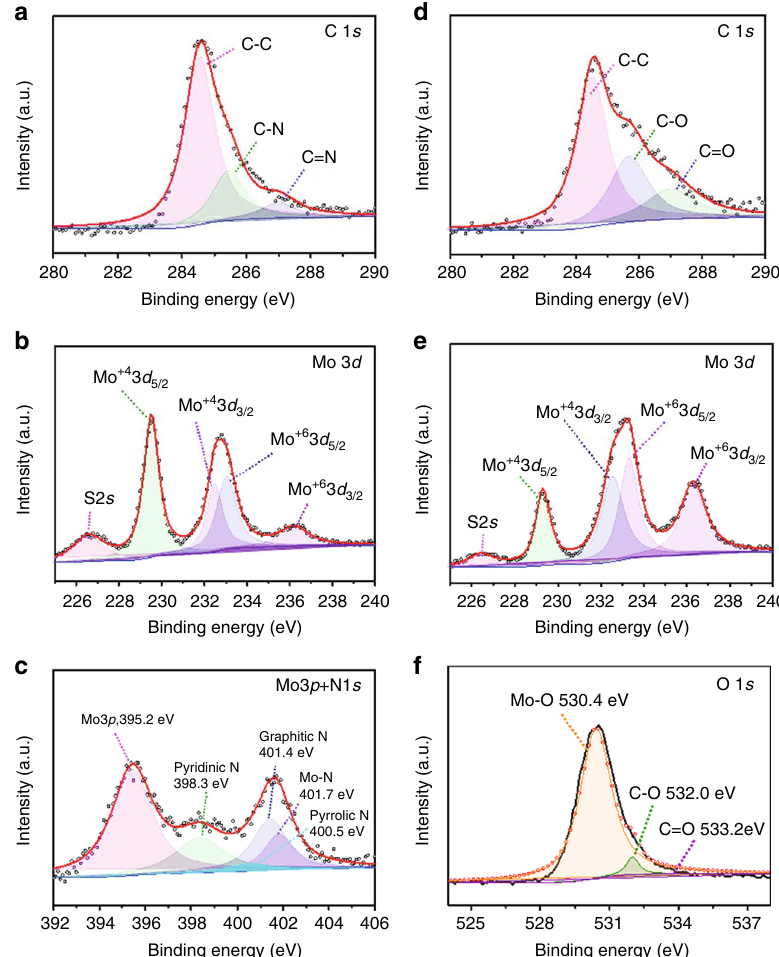
Fig. 5 X-ray photoelectron spectroscopy analyses. a – c High-resolution XPS spectra of C 1 s ( a ), Mo 3 d ( b ), and Mo 3 p + N 1 s ( c ) of the MoS 2 /NC heteroaerogels. d – f High-resolution XPS spectra of C 1 s ( d ), Mo 3 d ( e ), and O 1 s ( f ) of the MoS 2 /C